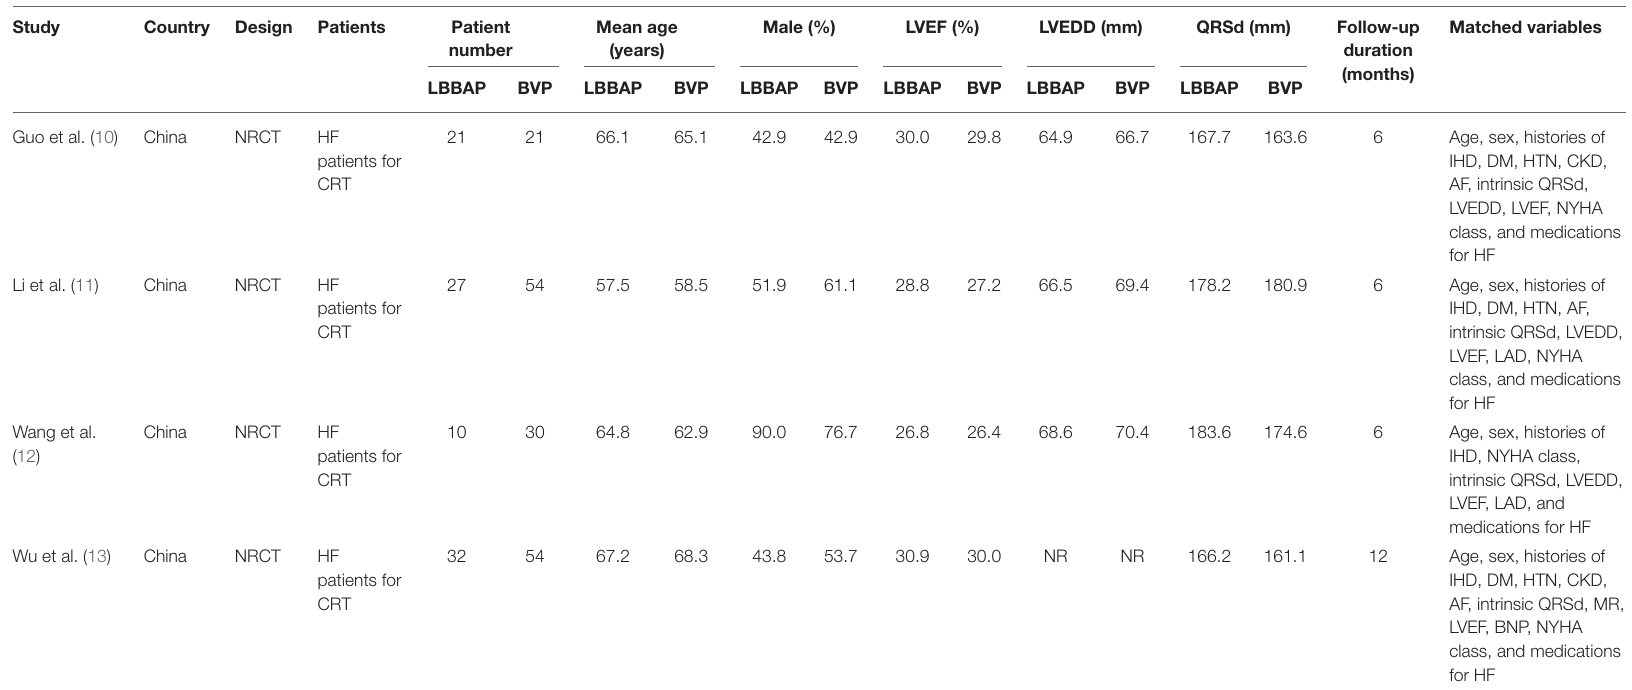
TABLE 1 | Characteristics of the included